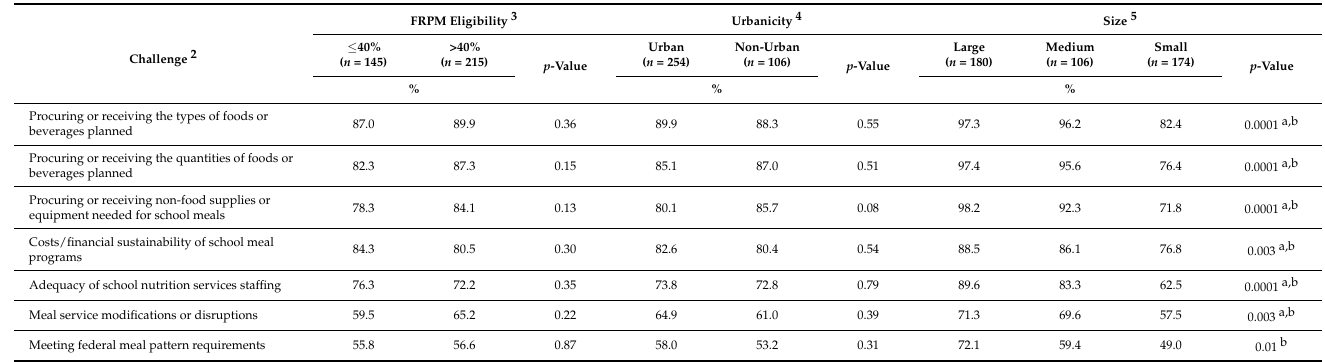
Table 4. Frequency of challenges with regard to school meals experienced in the SY 2021–22, using select SFA characteristics noted by the Californian school food authorities ( n = 581) 1 .